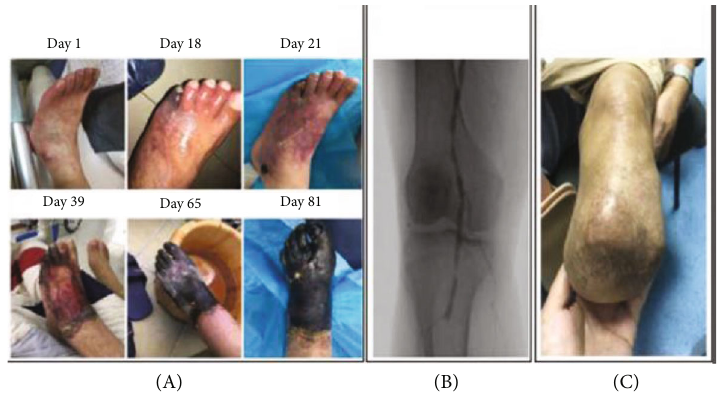
Figure 2: Amputation and endovascular therapy in diabetic lower limb